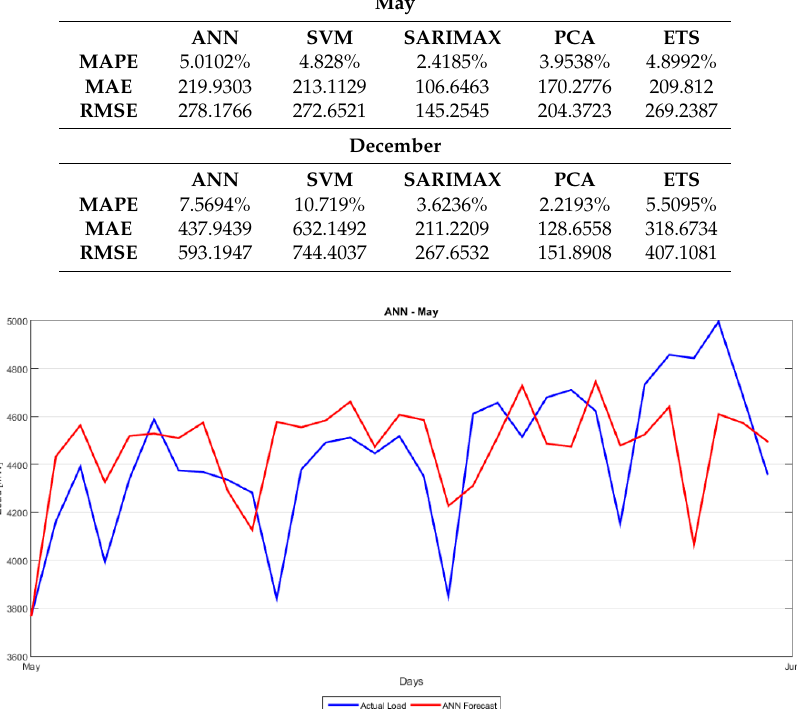
Figure 24. ANN forecast for May 2014.